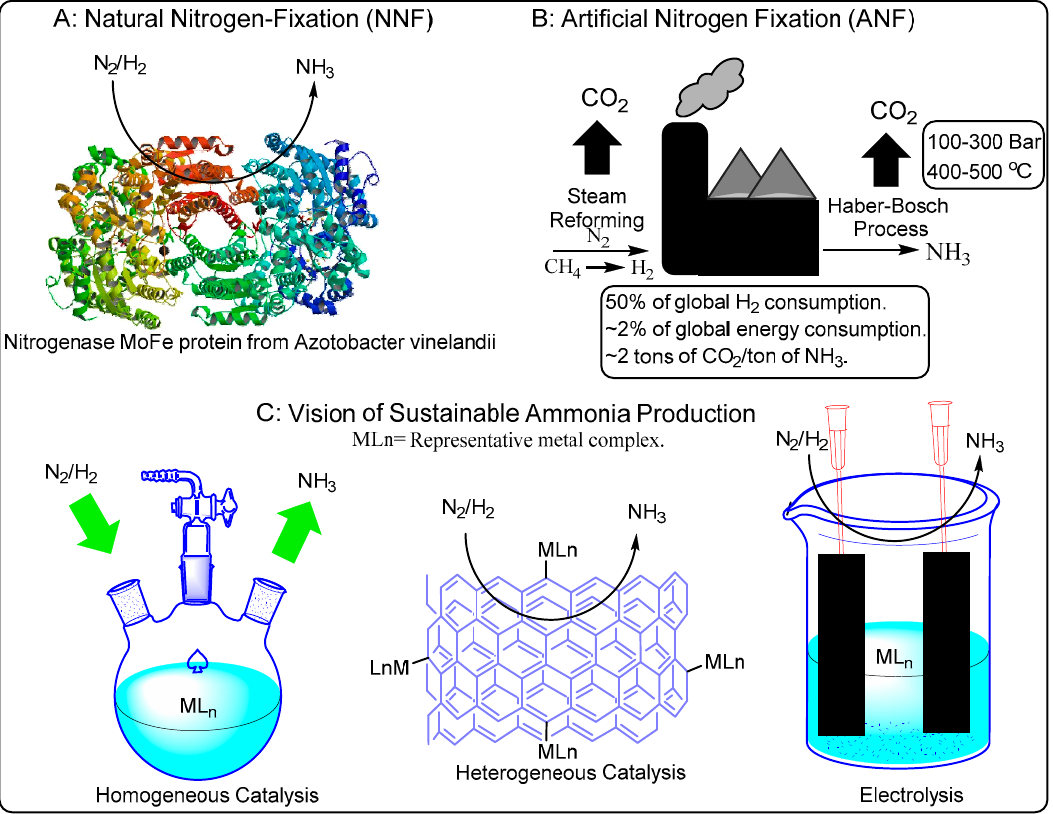
Figure 1. Nitrogen fixation, its problems and possible future developments. ( A ) Natural nitrogen fixation (NNF). ( B ) Current state of industrial nitrogen fixation. ( C ) Visions of sustainable ammonia production. Nitrogenase MoFe protein from Azobacter vinelandii (figure courtesy: Einsle, O., Tezcan, F.A., Andrade, S.L.A., Schmid, B., Yoshida, M., Howard, J.B., Rees, D.C. Database: RCSB. PDB).